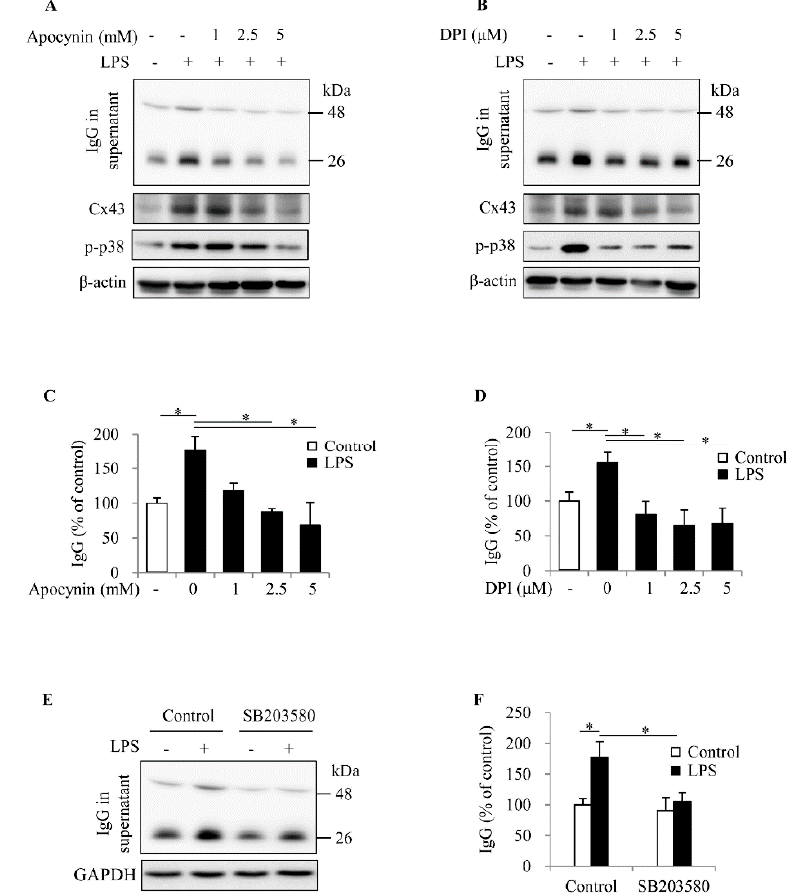
Figure 6. Effects of inhibition of NADPH oxidase (NOX) and p38 on LPS-induced production of IgG. ( A ) The isolated spleen cells were stimulated with 20 μ g/mL LPS in the presence or absence of the indicated concentrations of NOX inhibitors, APO and DPI, for 24 h. Supernatants and cellular proteins were harvested and assayed for IgG, Cx43 and p-p38 using Western blot analysis. The densitometric quantitation of IgG in ( A ) and ( B ) are shown in ( C ) and ( D ). Data shown are mean ± SE ( n = 3). * p < 0.05. ( E , F ) Effects of p38 inhibitor on LPS-initiated IgG secretion. The isolated spleen cells were treated with 20 μ g/mL LPS in the presence or absence of 10 μ M SB203580 for 24 h. Supernatants were collected and assayed for IgG. Cellular protein was assayed and used as an internal control. The densitometric quantitation of IgG in ( E ) is shown in ( F ). Data shown are mean ± SE ( n = 3). * p < 0.05.